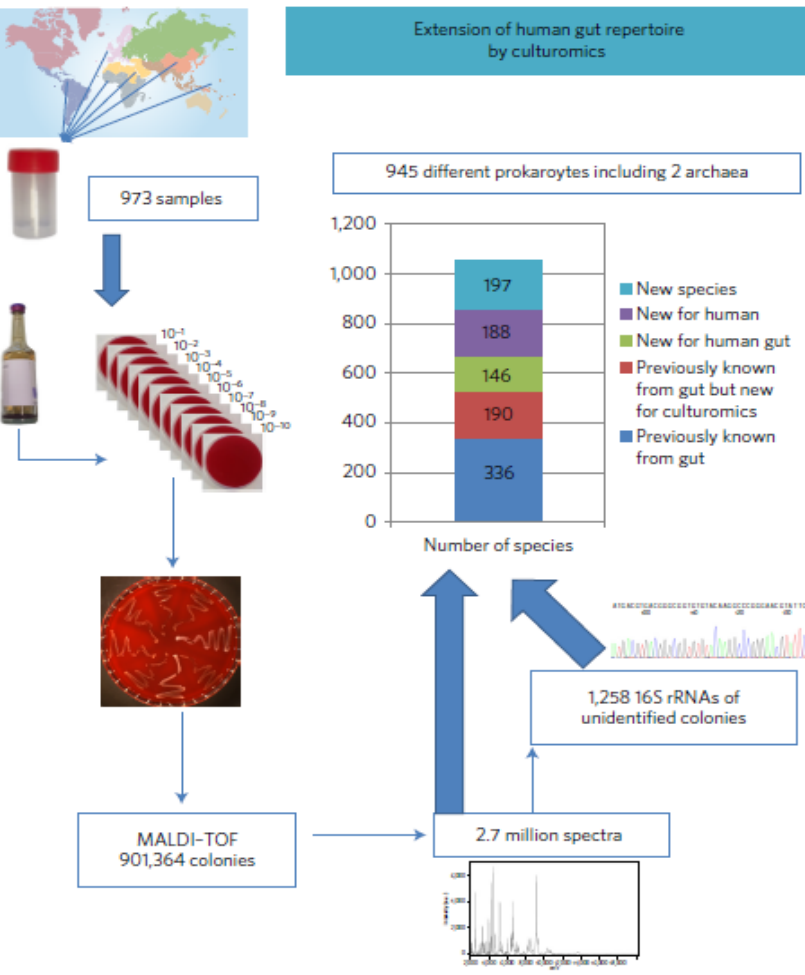
Figure 3. A stepwise outline of culturomics, enabling the culture of previously uncultured bacterial species in the human gut. Source: Lagier et al. [72] ( Nature Microbiology , Macmillan Publishers Limited) Licensed under CC BY 4.0.